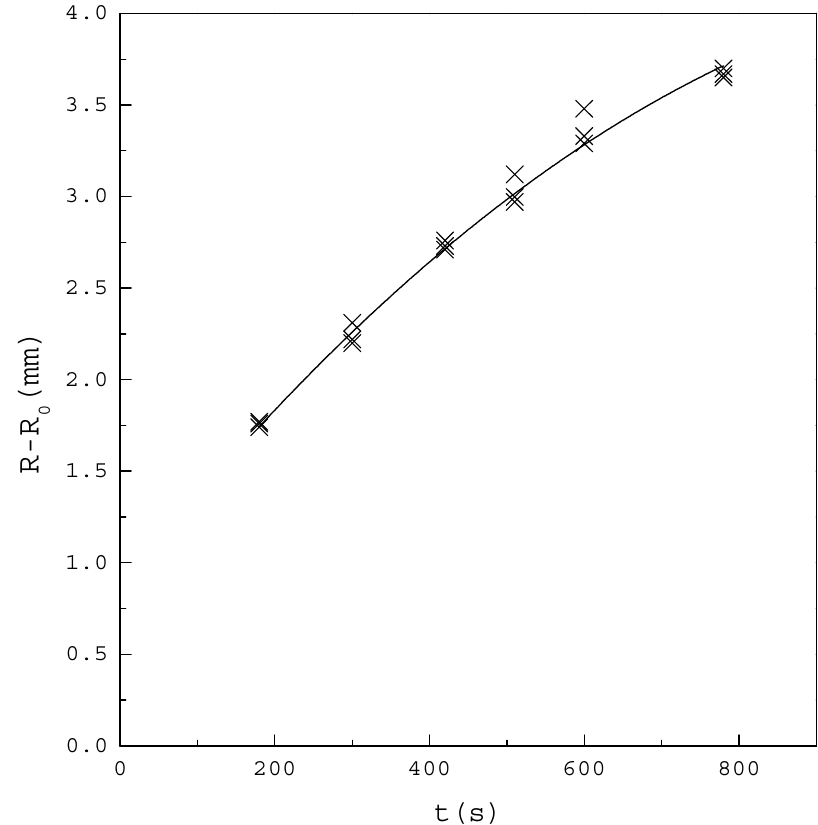
Figure 5. The increase of the crystal layer ( R − R 0 ) with increasing time for the binary PX / OX mixture with C mt,p = 0.90 (T (cid:2923)(cid:2930),(cid:2915)(cid:2927) = 282.2K) operated at T (cid:2887) = 265.7K . The points represent the experimental results and the line represent the fitted increasing trend of the crystal layer.